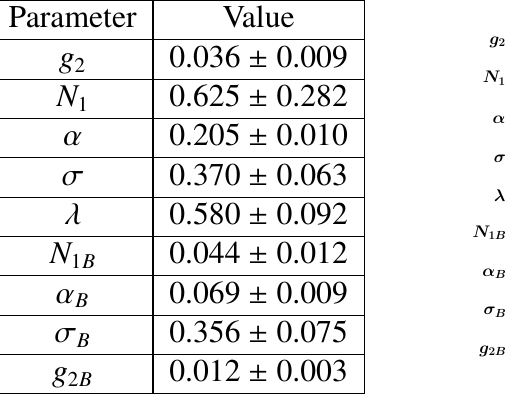
Table 5 . Average and standard deviation over the Monte Carlo replicas of the free parameters (cid:12)tted to the data and graphical representation of the correlation